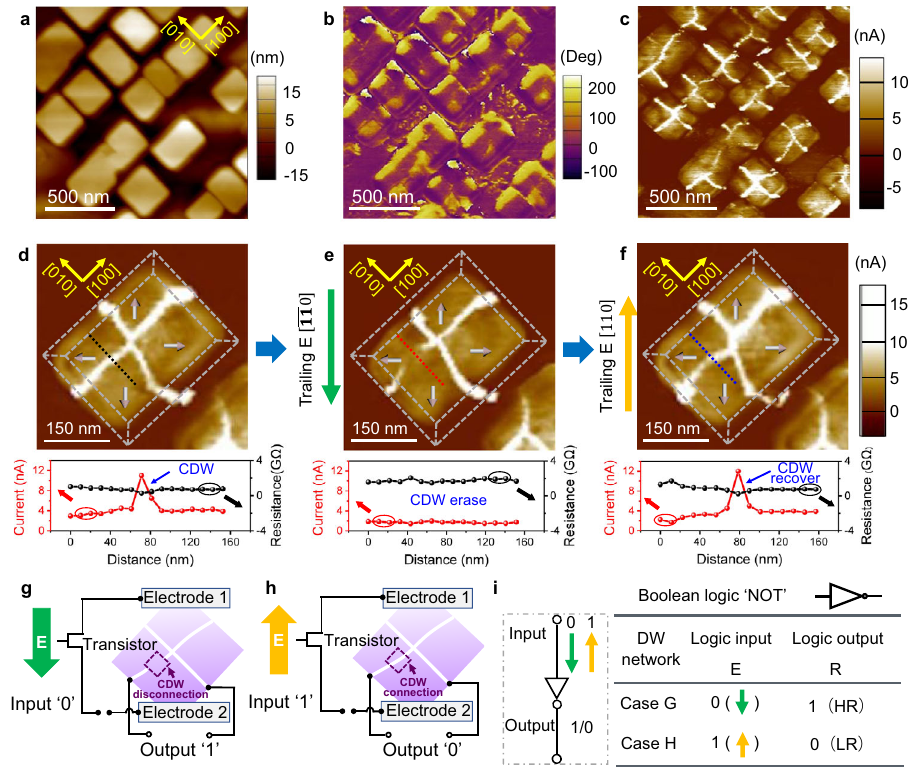
Fig. 1 Electric fi eld control of the on-and-off switching of a CDW and a NOT gate. a Morphology, b in-plane PFM phase, and ( c ) c-AFM image of vertex domains con fi ned in a rectangular BiFeO 3 nano-island array. d Initial cross-shaped CDW network with center-divergent (marked by three-dimensional arrows) vertex domains con fi ned in a rectangular BiFeO 3 nano-island. e Disconnection of a CDW branch by a [ (cid:1) 1 (cid:1) 10]-oriented (marked by the green arrow) trailing fi eld. f Reconnection of this disrupted CDW branch by a [110]-oriented (marked by yellow arrow) trailing fi eld. The curves below panels ( d – f ) are the corresponding current pro fi les along the dashed lines in ( d – f ). g , h Schematic of two logic operations of the NOT gate based on the experimental observations in ( e , f ), where [ (cid:1) 1 (cid:1) 10]- and [110]-oriented electric fi elds are de fi ned as logic inputs ‘ 0 ’ and ‘ 1 ’ , and the corresponding high and low resistance (HR and LR) states for the disconnected and connected CDW are de fi ned as logic outputs ‘ 1 ’ and ‘ 0 ’ , respectively. i Corresponding symbol (left) and truth table (right) for the NOT logic